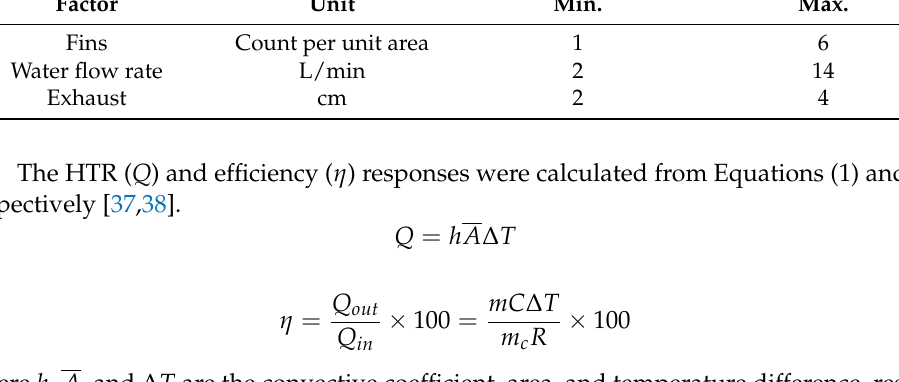
Table 2. Effective factors on the HE and their levels. Factor Unit Min. Max. Fins Count per unit area 1 6 Water flow rate L/min 2 14 Exhaust cm 2